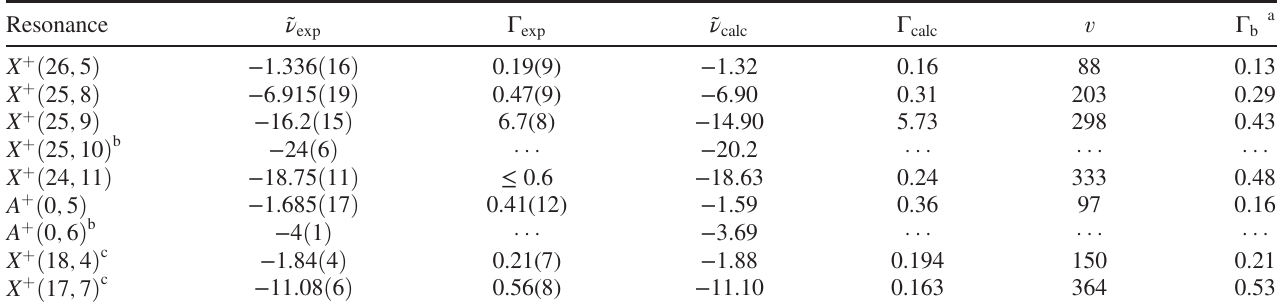
TABLE I. Experimental (exp) and calculated (calc) positions and widths (in cm − 1 ) of the observed shape resonances of D 2 þ and H 2 þ (last two lines) and corresponding asymptotic fragment velocities v (in m/s). Γ originating from the mechanism discussed in Sec. VA. The experimental uncertainties represent one standard deviation.